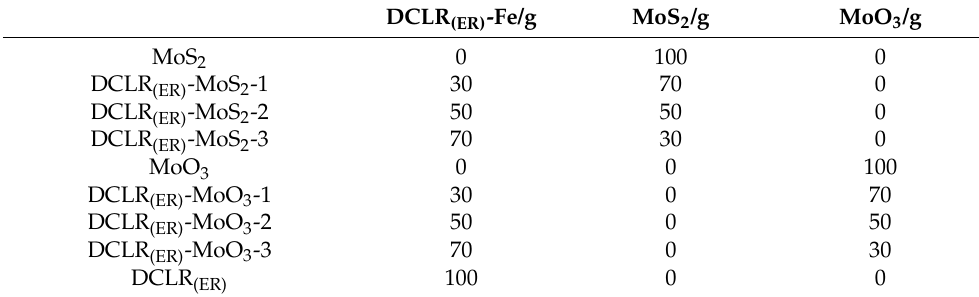
Table 7. Sample information.